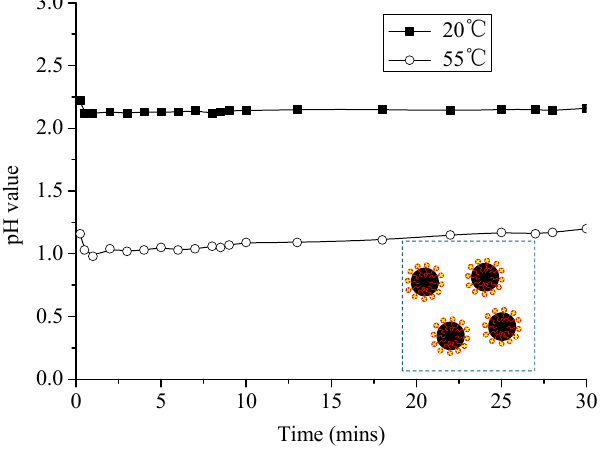
Figure 9. pH value of emulsified asphalt–water system changes with time at different temperatures.